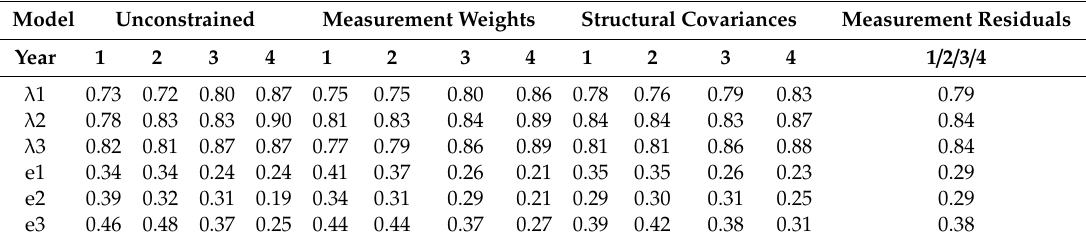
Table 4. Standardized parameter estimates of models.